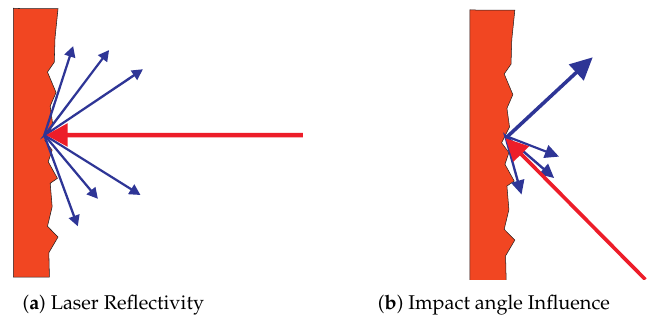
Fig. 8: Reflection angle